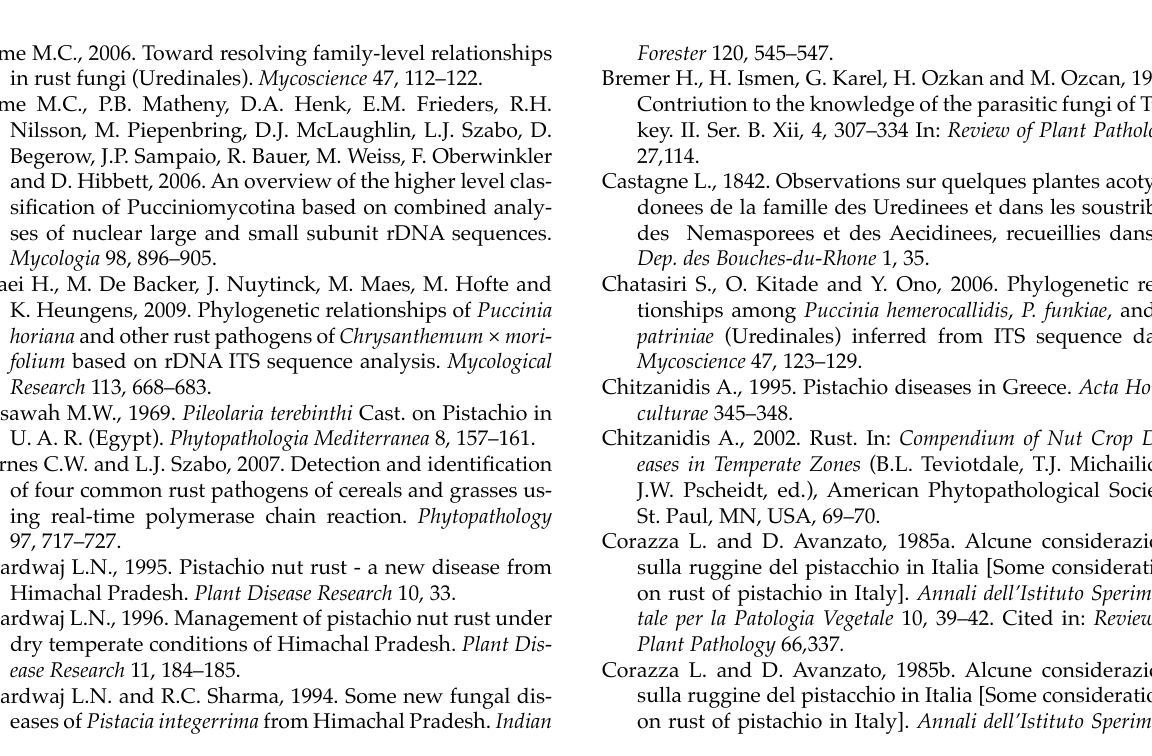
Figure 3. Agarose gel electrophoresis pattern of the amplified rDNA ITS region of pistachio and almond rust specimens digested with XapI (ApoI) using primer combination of ITS1F-ITS4 (A) and ITS1F-rust1 (B); Marker 100 bp (M), Pileolaria terebinthi Lane 1A (clone 02) and Lane 2A (clone 03), Tranzschelia discolor Lane 3A (clone 01) and Lane 4A (clone 03). Pileo- laria terebinthi Lane 1B (clone 07), Tranzschelia discolor Lane 2B (clone